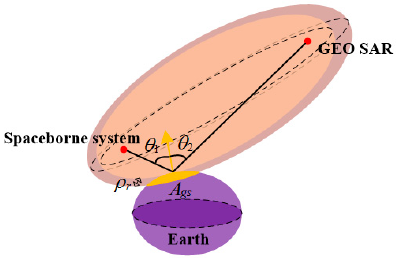
Figure 5. Formation of the specular scattering area.